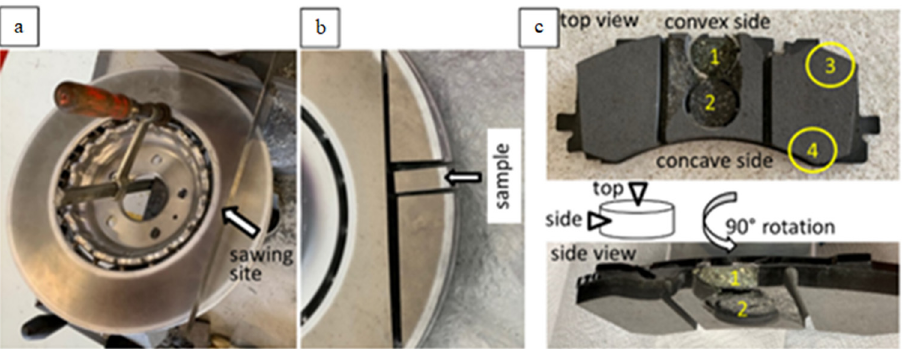
Figure 1. Macro-photographs of the disc ( a , b ) and of the pads ( c ) showing the sampling sites on top view and side view, as well as a sketch of the examined samples marking top and side view (arrows). Brake pads: Four samples from the new and four from the used pad (two from the